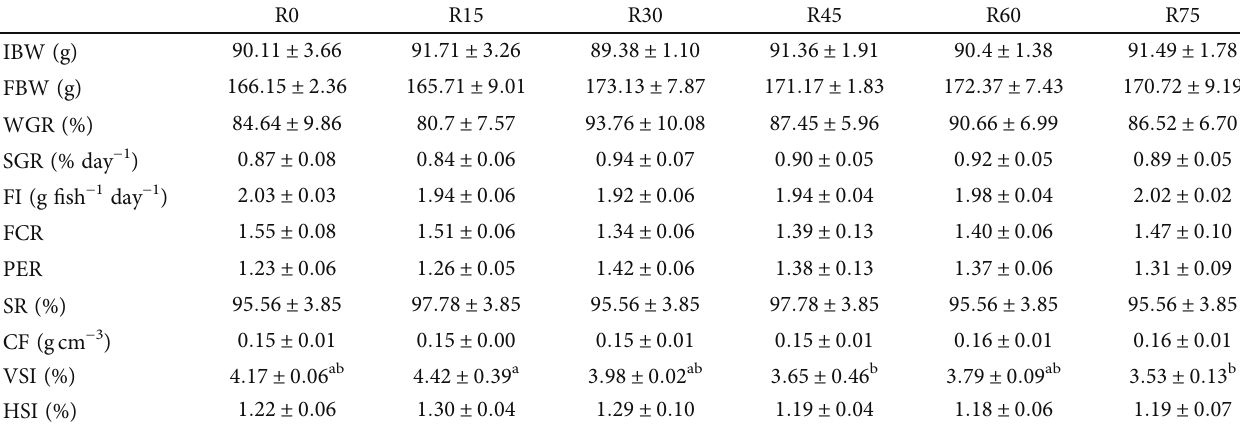
Table 4: Growth performance and somatic indices of Japanese eel fed with di ff erent replacement levels of DBSFLM. R0 R15 R30 R45